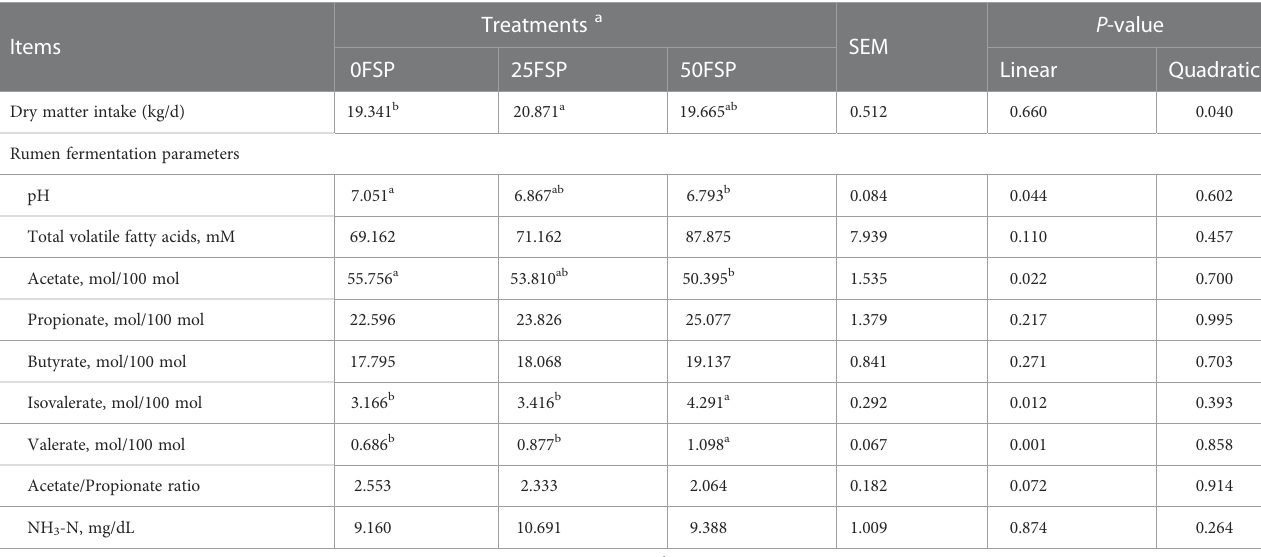
TABLE 3 Dry matter intake and rumen fermentation parameters of early lactating Holstein dairy cows (n = 8 per treatment) fed a basal diet supplemented with fennel seed powder (FSP).